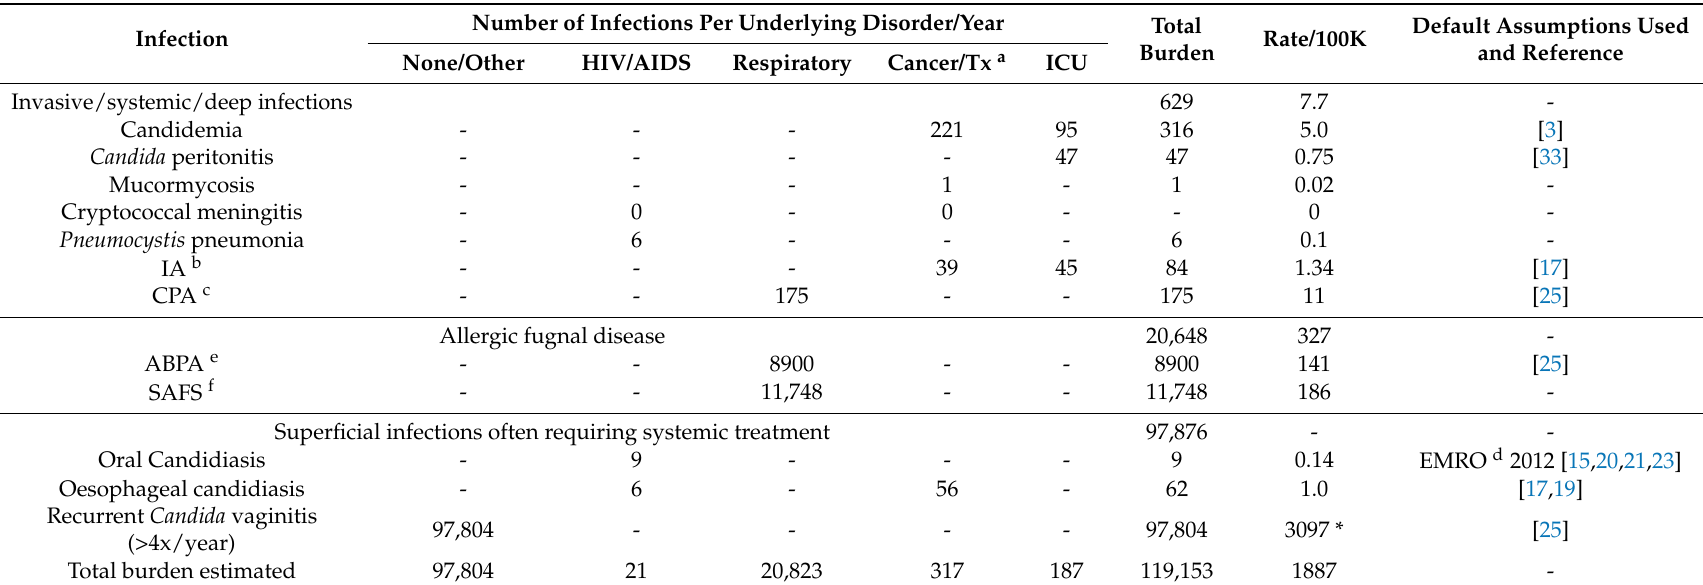
Table 1. Total burden of fungal infections per the underlying disorder and per year in